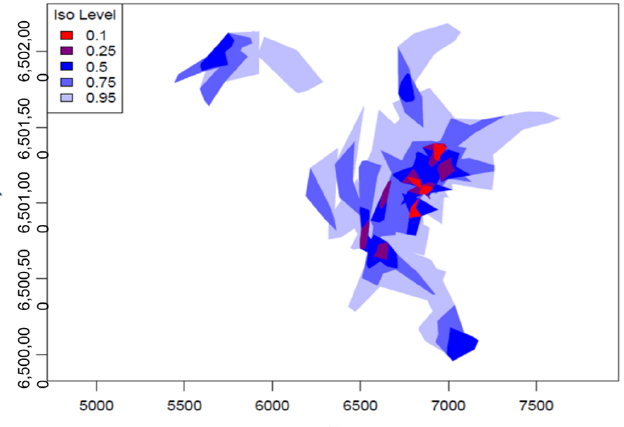
Figure 2. An isopleth constructed in different hulls sorted by area, indicating proportions of the total points enclosed by focal cattle during the wet season.